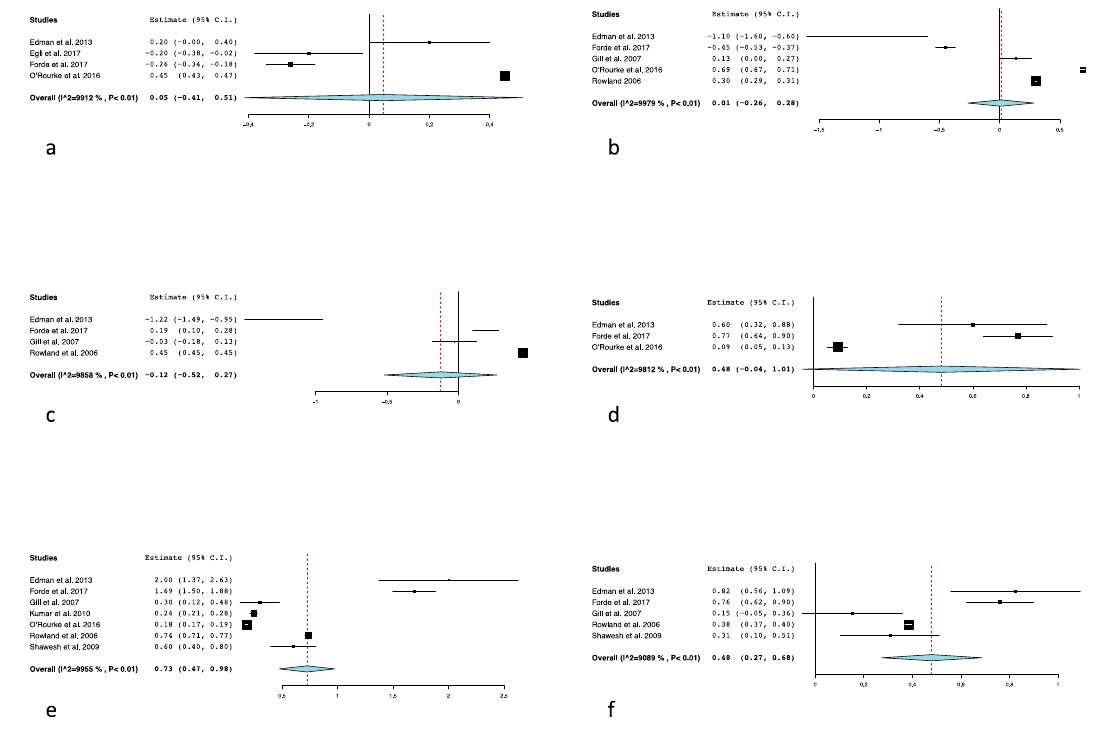
Figure 2. Figure 2. ( a ) Forest plot of the intercanine width modification: mandibular fixed retainers; ( b ) mandibular removable retainers; ( c ) maxillary removable retainers; ( d ) forest plot of the Little’s Index